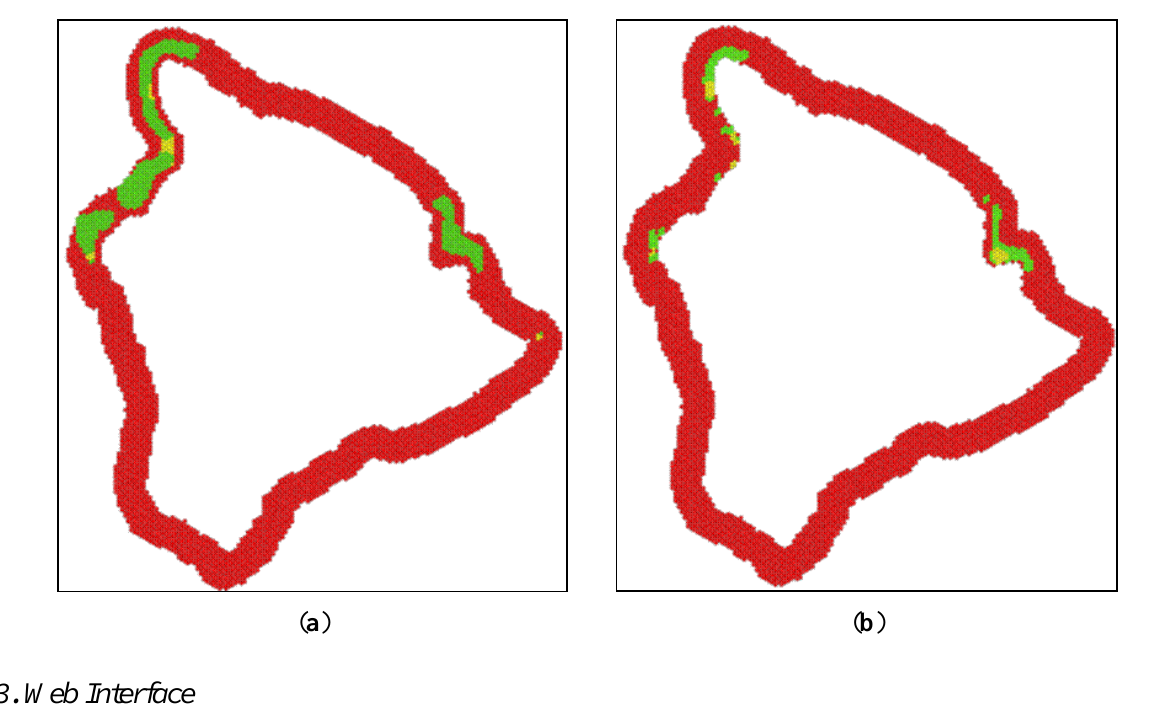
Figure 2. Suitability of sites for line culture, moored cages, and intertidal/subtidal bottom culture. Green hexagons identify areas suited for marine aquaculture, yellow hexagons include cautionary areas, and red hexagons are unsuitable. ( a ) 5180 ha are suitable for Line Culture and Moored Cages; ( b ) 1750 ha are suitable for Intertidal/subtidal Bottom